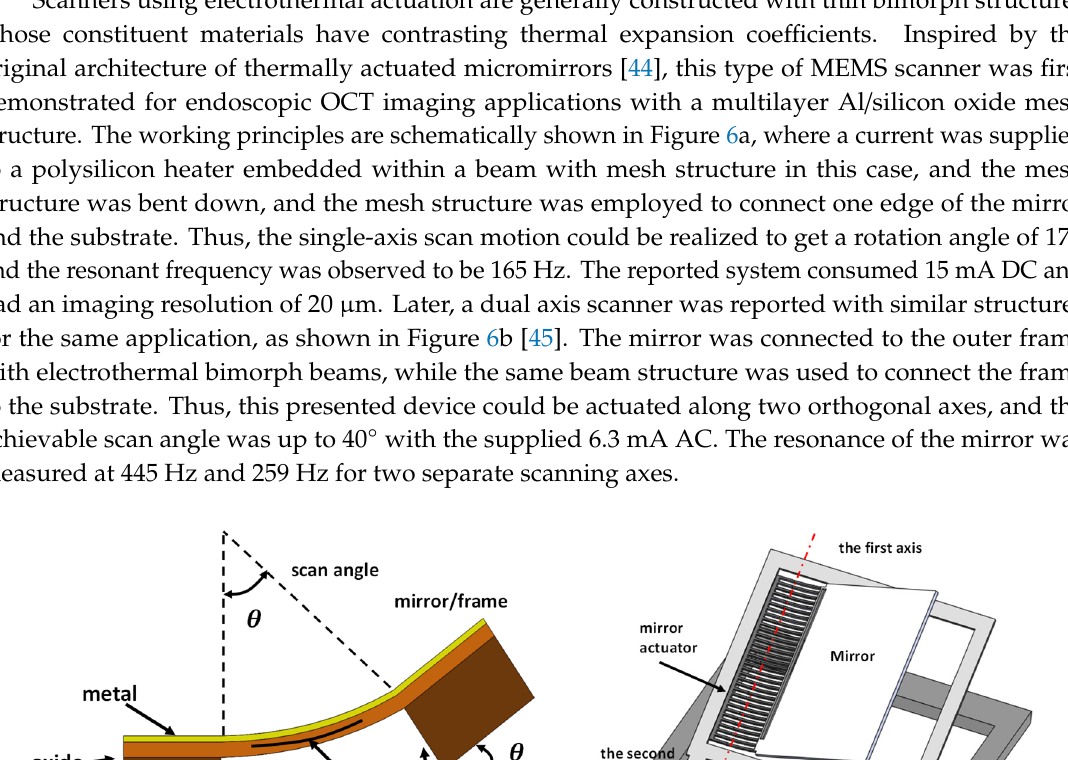
Figure 5. Mechanical structures of ( a ) the MEMS scanners indirectly actuated by a 13%-Nb-doped PZT (PNZT) cantilever beam [40]; ( b ) the MEMS scanners actuated by active lead zirconate titanate (PZT) legs to achieve the vertical translation and rotated by the mechanical couple into the gimbal platform [41].